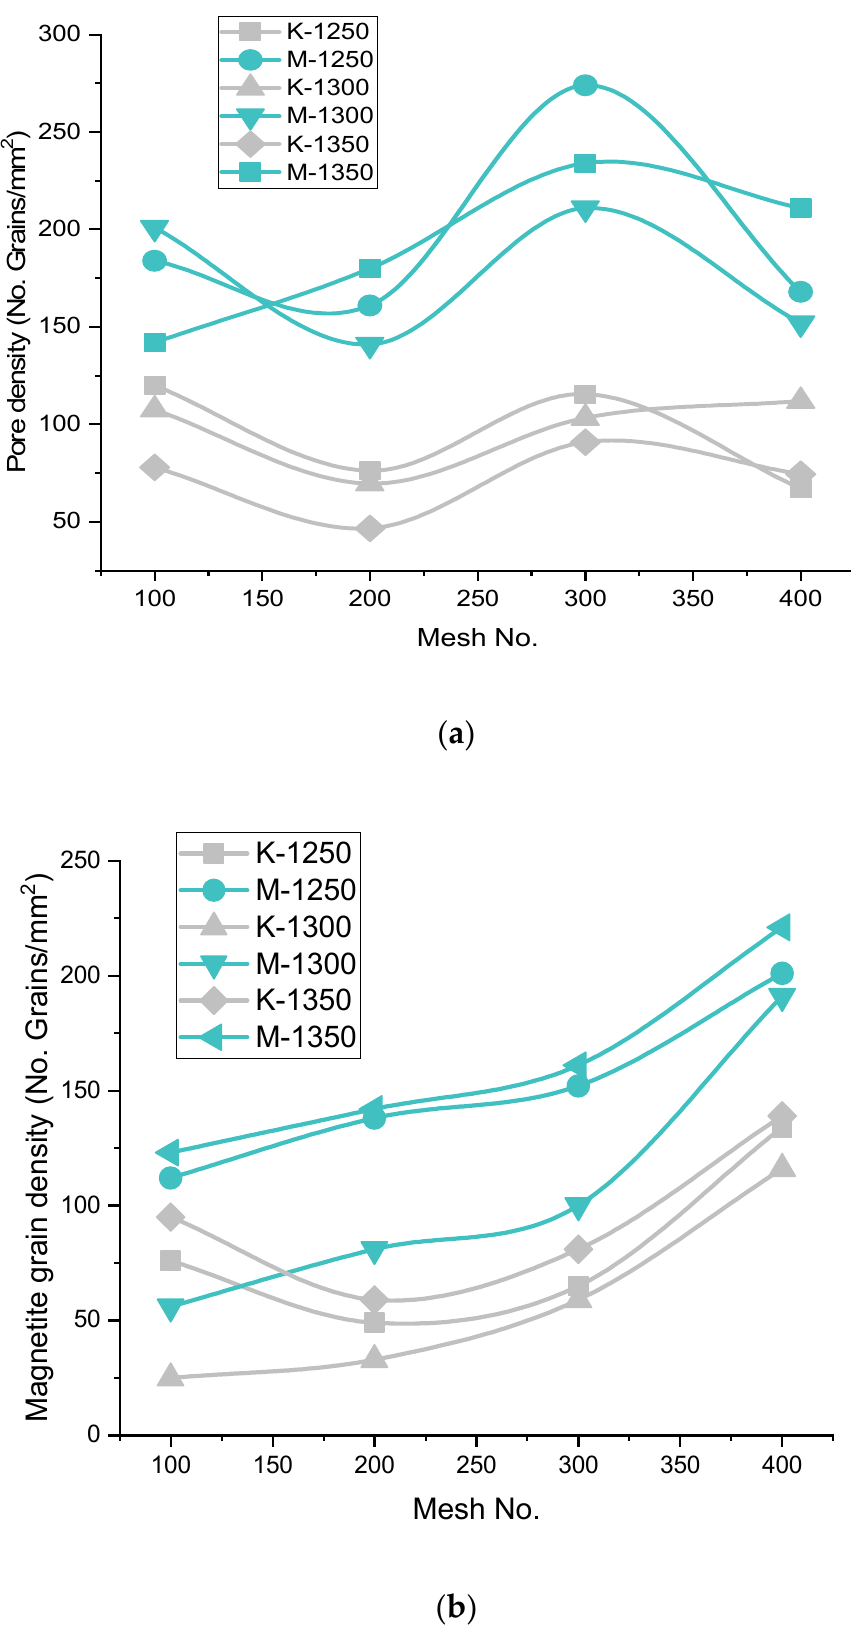
Figure 10. Effect of Mesh no. on Phase Grain density of ( a ) Pores ( b ) Magnetite. Magnetite Phase Grain Density (M.P.G.D.)